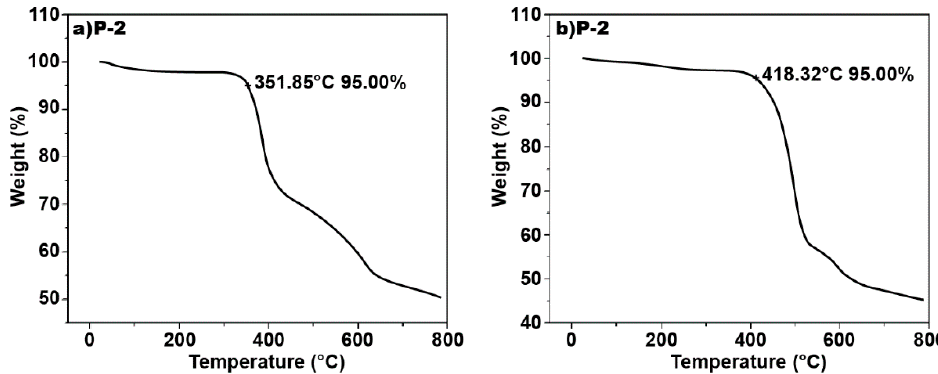
Figure 6. Thermogravimetric analysis (TGA) plots of two representative ionic polymers P-2 and P-4 obtained at a heating rate of 10 °C/min in nitrogen.